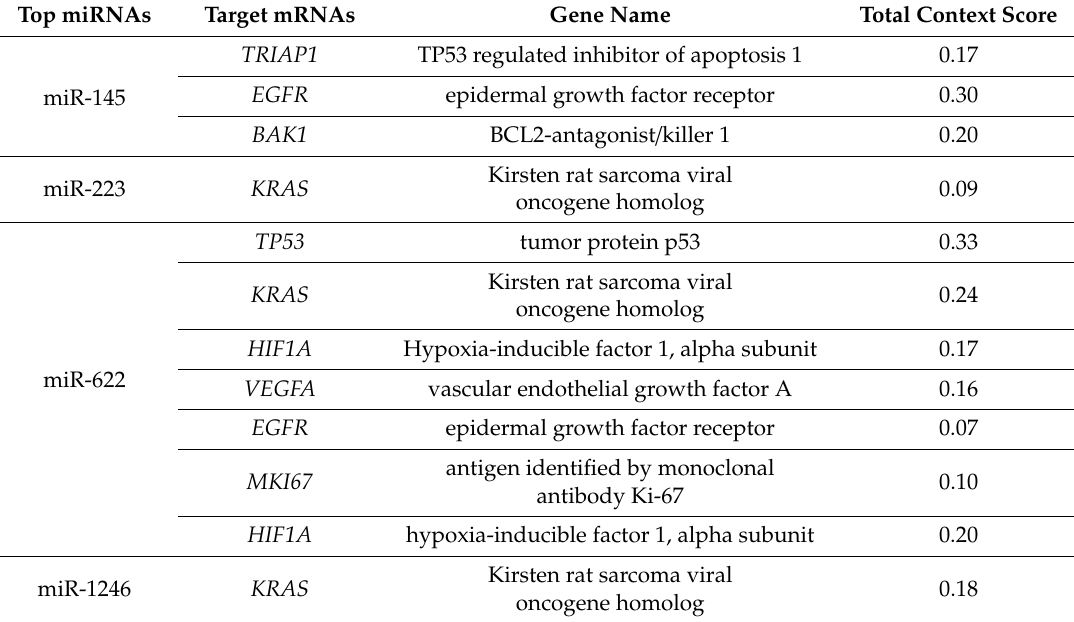
Table 1. Top miRNAs predictors of neoadjuvant chemoradiotherapy (nCRT) response. Targeted genes were identified with TargetScan database. Only miRNAs for whom target mRNA were found in included articles are